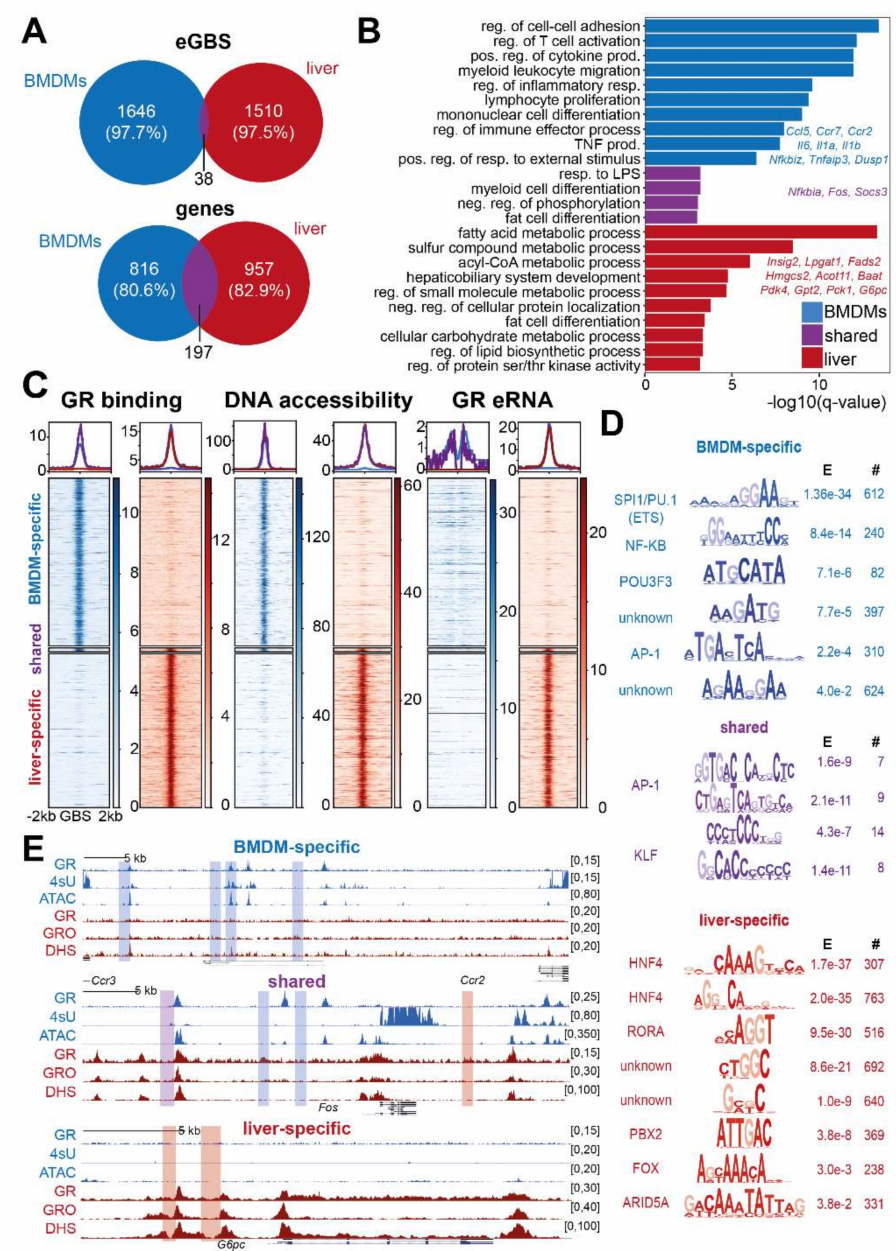
Figure 2. GR-mediated eRNA expression patterns are tissue specific. ( A ) Venn diagram for over- lapping eRNA-expressing GR binding sites (eGBS) and their nearest target genes in liver and macrophages (BMDMs). ( B ) Functional annotation for the genes associated with eGBSs specific to macrophages or livers (top 10 non-redundant biological processes q -value < 0.001, with examples). neg. = negative, pos. = positive, prod. = production, reg. = regulation, resp. = response ( C ) Heatmap of GR ChIP-seq, open chromatin (macrophage ATAC-seq, liver DHS) and nascent transcription (macrophage 4sU, liver GRO-seq). Heatmaps display the mean signal intensity across biological replicates. Coverage plots show the median signal per subset (blue=macrophage-specific, red=liver- specific, purple=shared). ( D ) Differential XSTREME motif analysis [68] of macrophage-specific, shared and liver-specific eGBSs. E = E-value; # = number of sites. ( E ) Example genome browser tracks for macrophage-specific ( Ccr2/Ccr3 ), shared ( Fos ) and liver-specific ( G6pc ) eGBSs showing mean GR ChIP-seq signal, nascent transcription profiled by 4sU-seq in macrophages and GRO-seq in livers and open chromatin (macrophage ATAC-seq, liver DHS) (GR ChIPseq n = 2, ATAC-seq n = 4, DHS n = 1, 4sU n = 3, GRO-seq n =